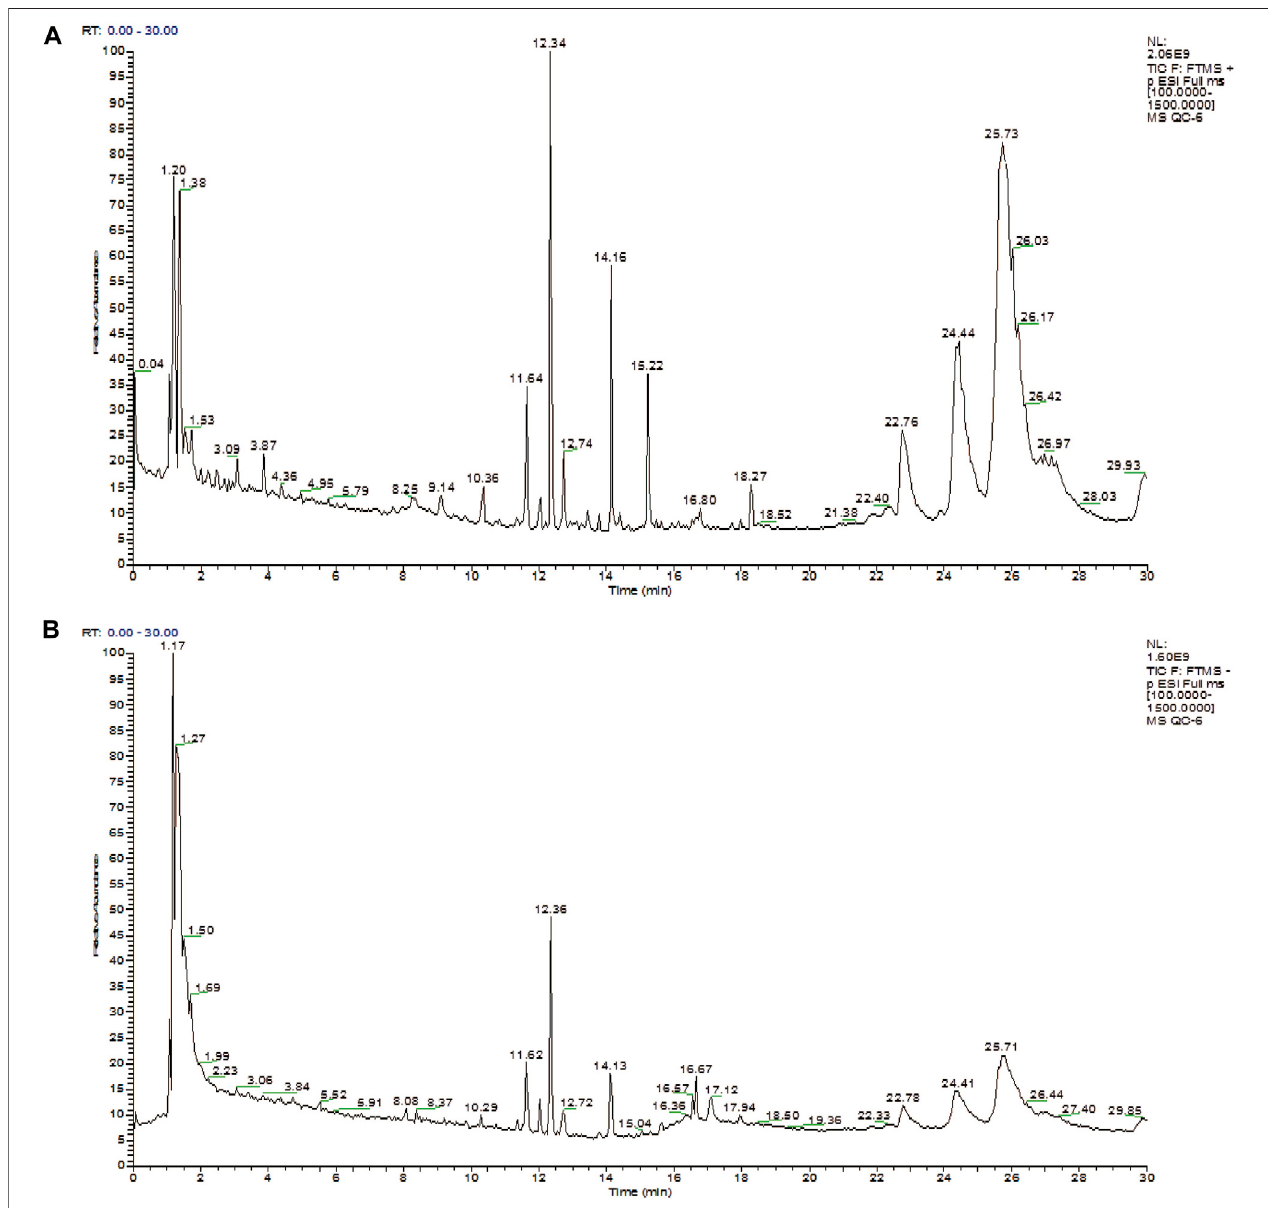
FIGURE 1 | Total ion chromatography (TIC) pro fi ling of plasma sample ( A : positive ion mode, B : negative ion mode).